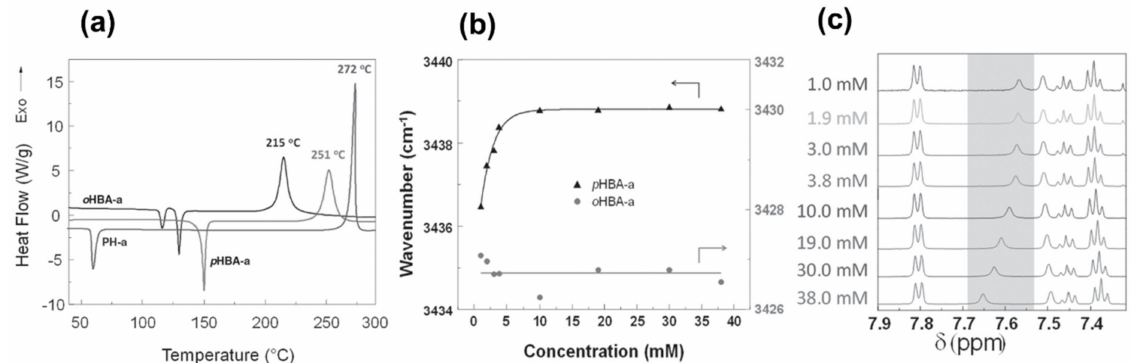
Figure 71. Effect of inter- and intramolecular H-bonding interactions in o HBA-a and p HBA-a vs PH-a: ( a ) DSC thermograms. ( b ) Variation in N-H stretching wavenumber vs concentration. ( c ) 1 H NMR spectra of p HBA-a at different concentrations (recorded at 25 ◦ C using CDCl 3 as a solvent) [243]. Copyright 2017. Reproduced with permission from WILEY-VCH Verlag GmbH & Co. KGaA, Weinheim, Germany.